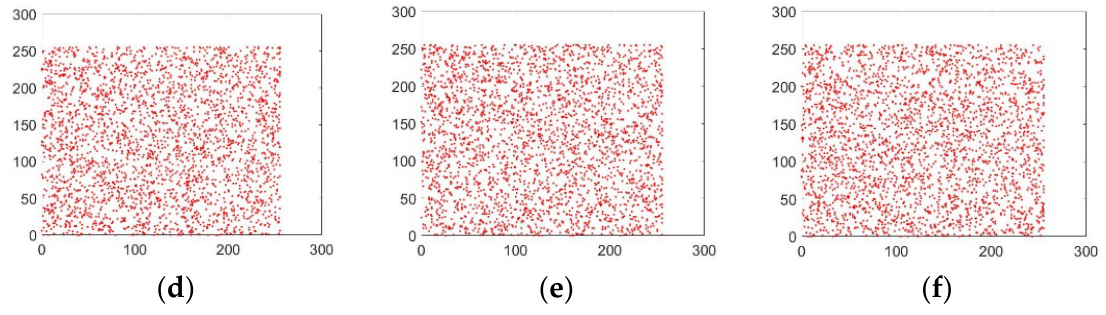
Figure 9. The adjacent pixel correlation distribution with directions: ( a ) horizontal component of the input Lena plain image; ( b ) vertical component of the input Lena plain image; ( c ) diagonal component of the input Lena plain image; ( d ) horizontal component of the generated Lena encrypted image; ( e ) vertical component of the generated Lena encrypted image; ( f ) diagonal component of the generated Lena encrypted image.